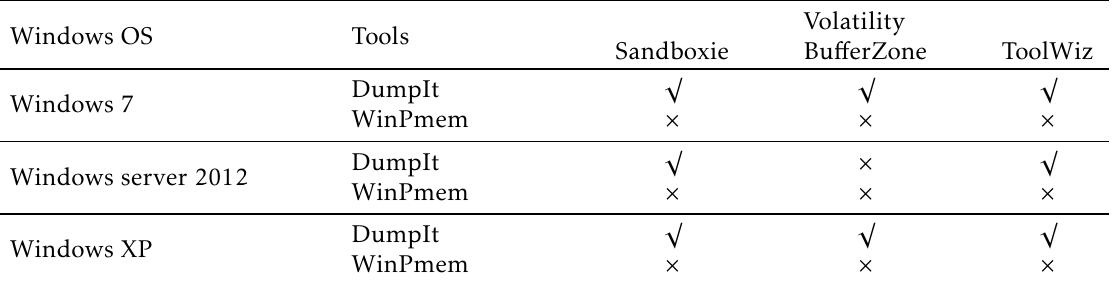
Table 7. Volatility analysis process